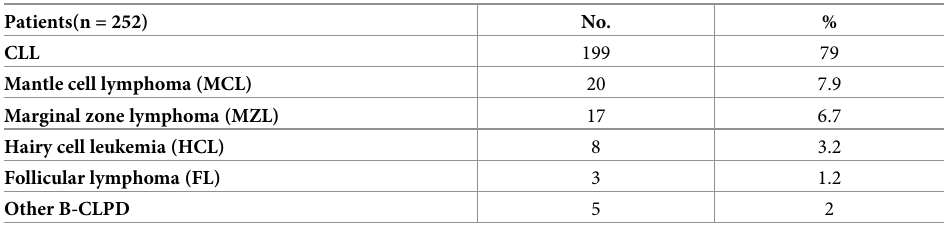
Table 1. Diagnosis of 252 cases with suspected B-chronic lymphoproliferative disorders. Patients(n =